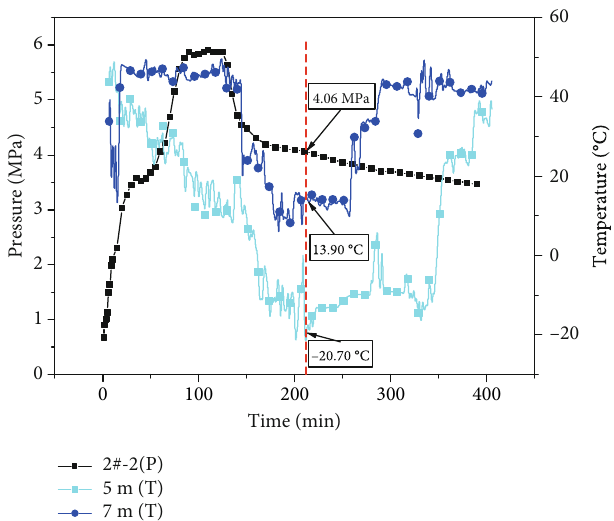
Figure 7: Temperature-pressure